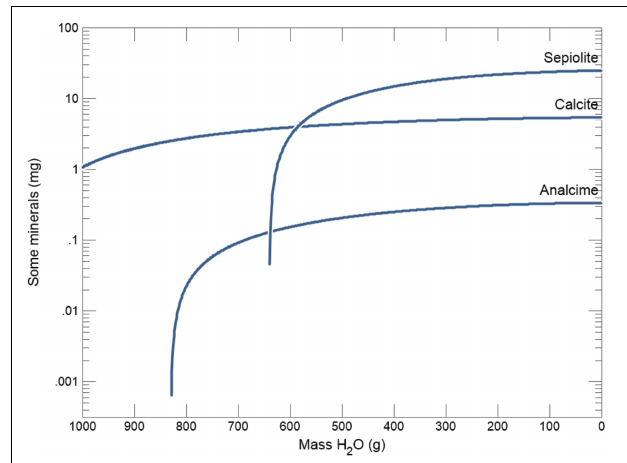
FIGURE 11 | Modeled hydrochemical evolution and mineral reaction pathways in the Chew Bahir basin showing the immediate precipitation of calcite, and followed by analcime and sepiolite, calculated based on Lake Chamo dissolved solid composition ( Table 2 ; Ayenew, 2005).